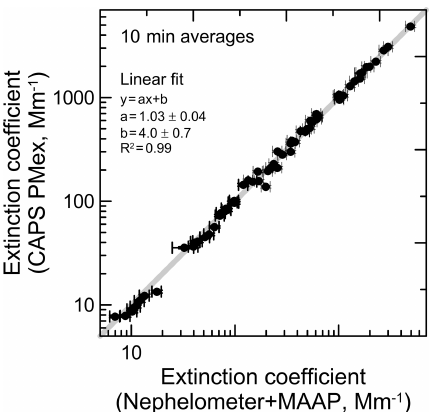
Figure 4. CAPS PMex extinction coefficient extrapolated at 660nm versus nephelometer and MAAP calculated extinction at 660nm for all experiments (dust, kaolinite, ambient air). Each point in the plot corresponds to 10min average data. The y = x line and the results of the linear fit between CAPS and nephelometer and MAAP data are also shown in the